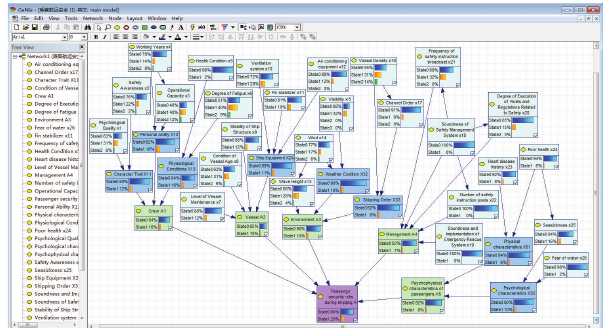
Figure 3: GeNIe simulation of Bayesian network based on historical